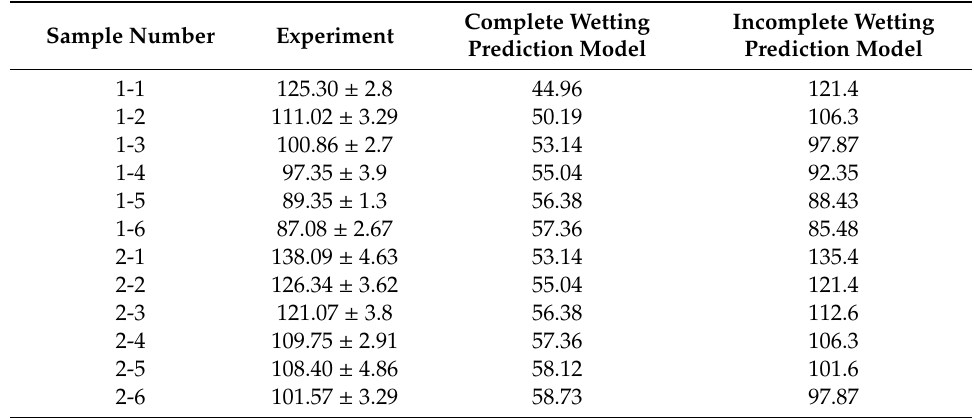
Table 2. The predicted and experimental values of contact angle.